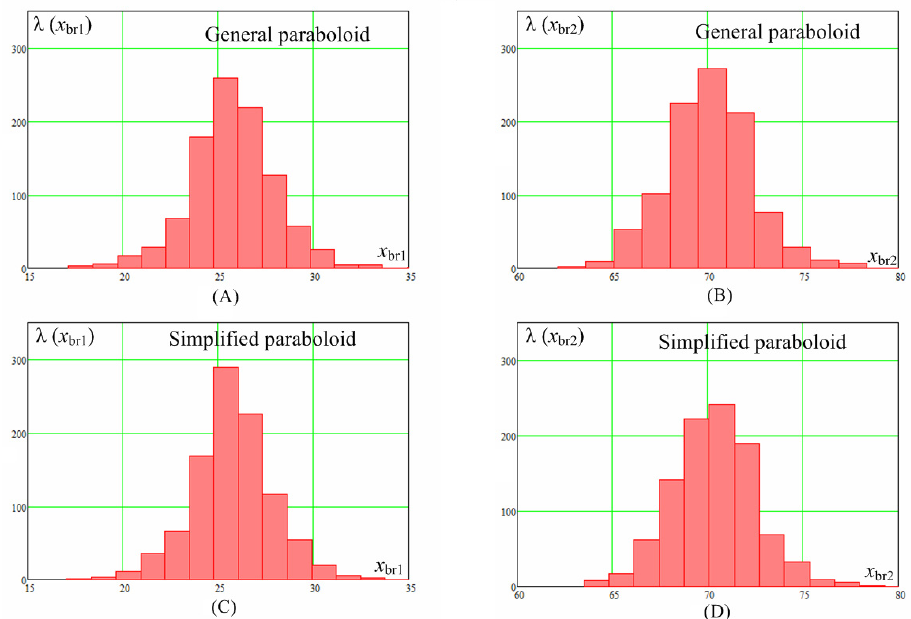
Figure 6. Histograms for breakpoint abscissas for different optimization options: ( A )—estimates of the first breakpoint for general paraboloid; ( B )—estimates of the second breakpoint for general paraboloid; ( C )—estimates of the first breakpoint for simplified paraboloid; ( D )—estimates of the second breakpoint for simplified paraboloid.